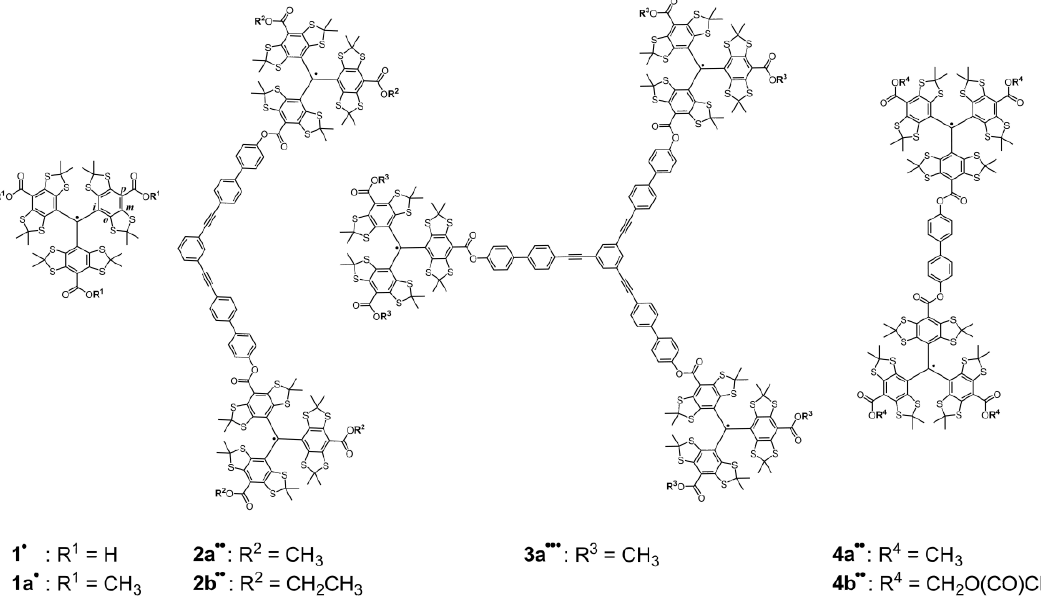
Figure 1. Lewis structures of the Finland Trityl 1 • , its methyl ester derivative 1a • and of the five model compounds 2a •• , 2b •• , 3a ••• , 4a •• and 4b •• . The ipso , ortho , meta and para positions in the phenyl rings are indicated in molecule 1 • by the letters i , o , m and p , respectively.